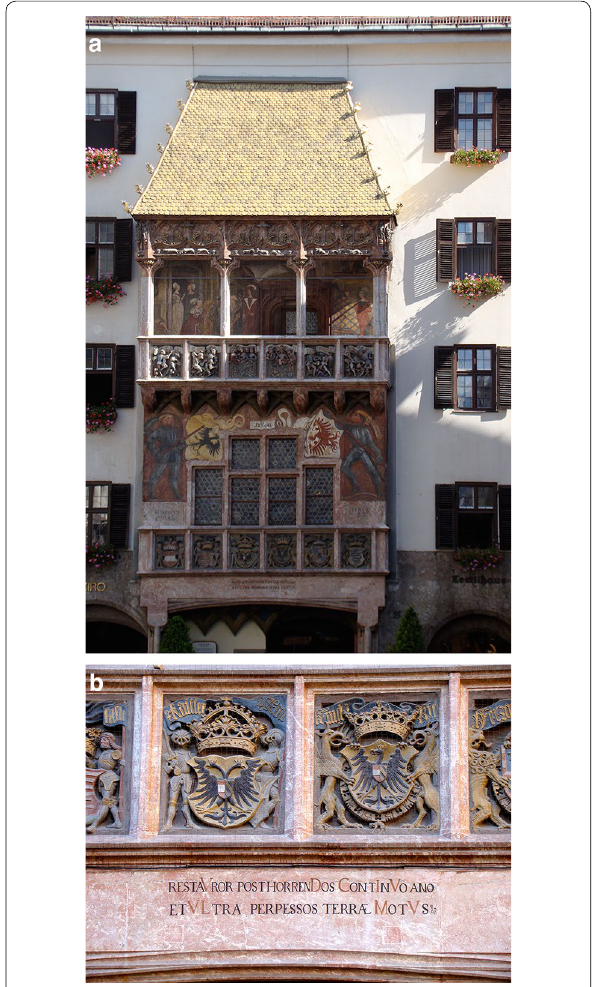
Fig. 4 a , b An inscription ( b ) on the so-called “Goldenes Dachl” (Golden Roof) ( a ), an Innsbruck landmark, serves as a reminder